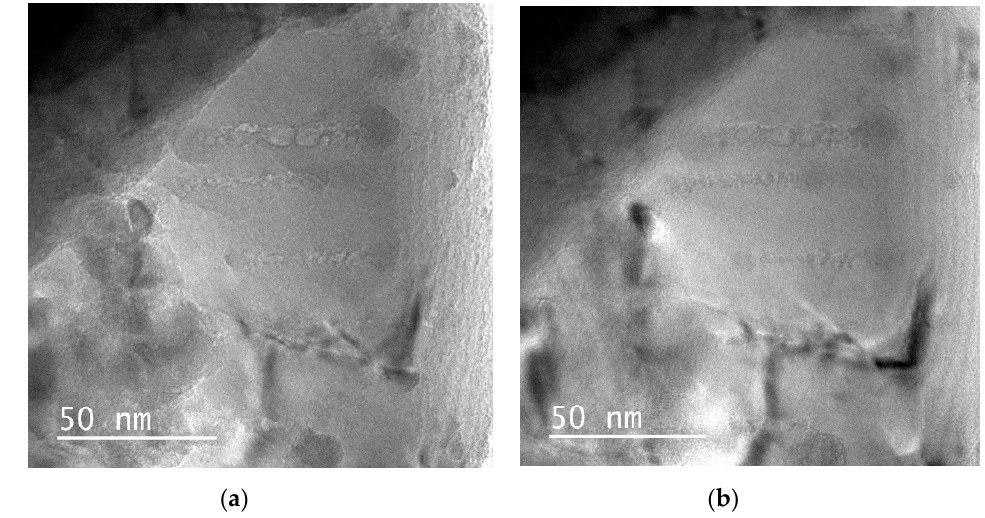
Figure 5. Bright field images of ion tracks induced in Nb-doped SrTiO 3 irradiated with 200 MeV Au 32+ at an oblique incidence angle. The images were taken in ( a ) underfocus condition and ( b ) overfocus condition.